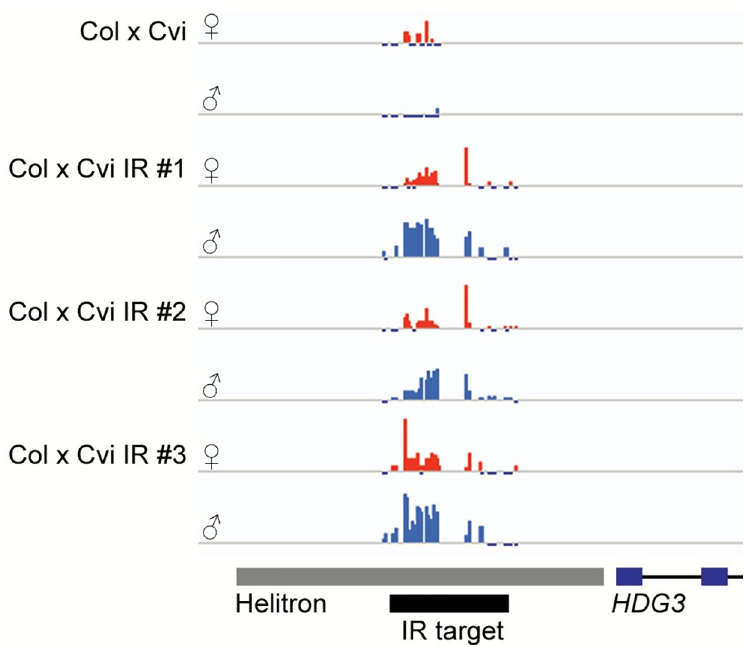
Fig 4. Gain of Cvi HDG3 paternal allele methylation in endosperm. Total methylcytosine 5’ of HDG3 in F 1 endosperm, determined by bisulfite-PCR. Maternally inherited Col allele in orange, paternally inherited Cvi allele in blue. Scale to 100%, tick marks below line indicate unmethylated cytosines. Col x Cvi data published in